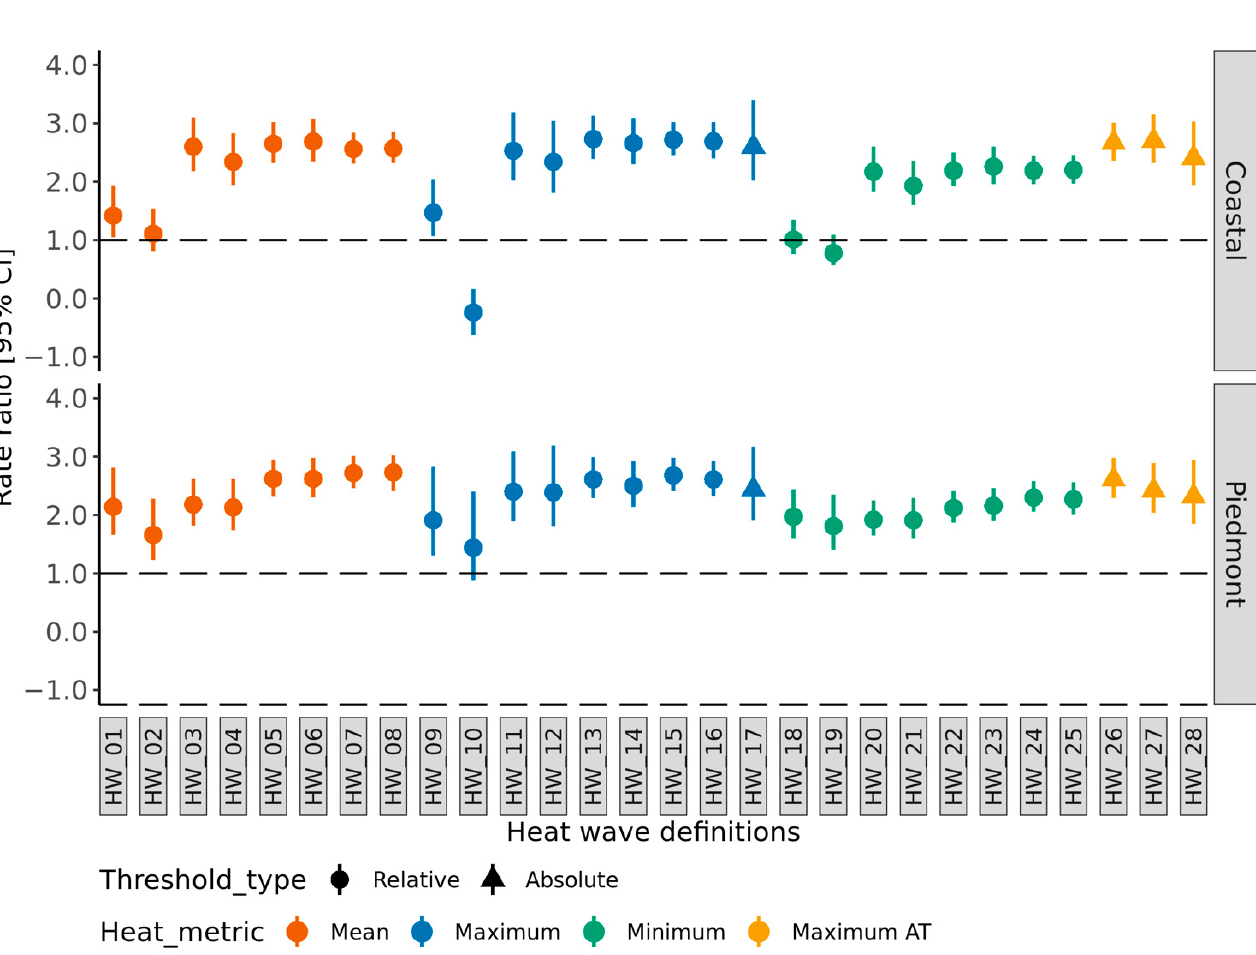
Figure 2. HRI rate ratio corresponding to heat wave definitions. The rate ratios and the corresponding 95% confidence intervals were generated using the generalized linear model (GLM), assuming a negative binomial distribution. The X -axis represents distinct heat wave definitions, stratified by North Carolina physiographic regions and grouped by metric and threshold type. The Y -axis represents the HRI morbidity rate ratio, which could be interpreted as an increase/decrease in HRI morbidity rate during a heat wave day compared to a non-heat wave day.